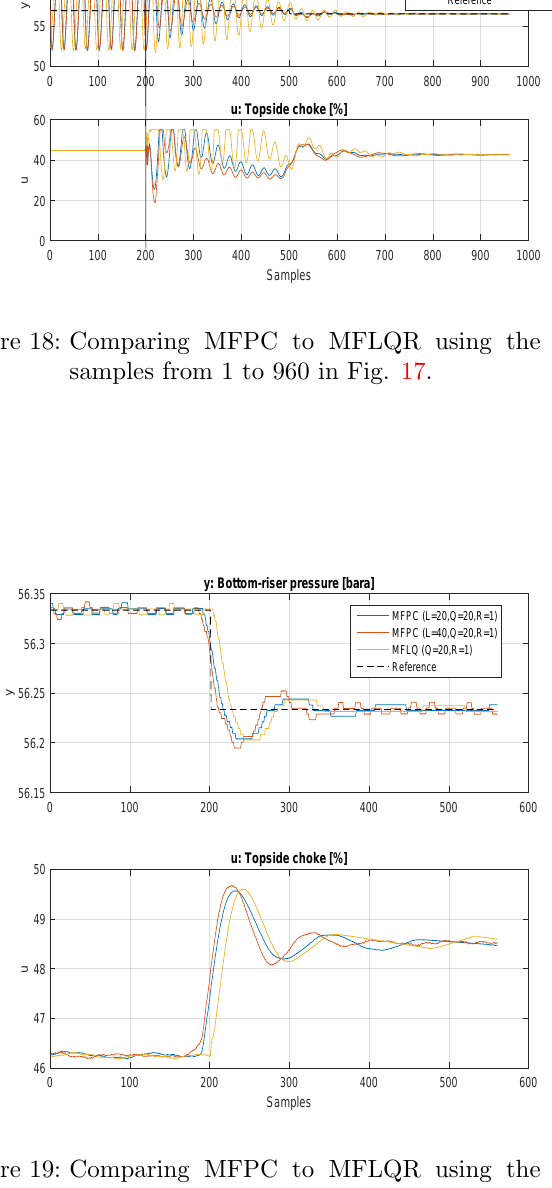
Figure 19: Comparing MFPC to MFLQR using the samples from 1300 to 1860 in Fig. 17.